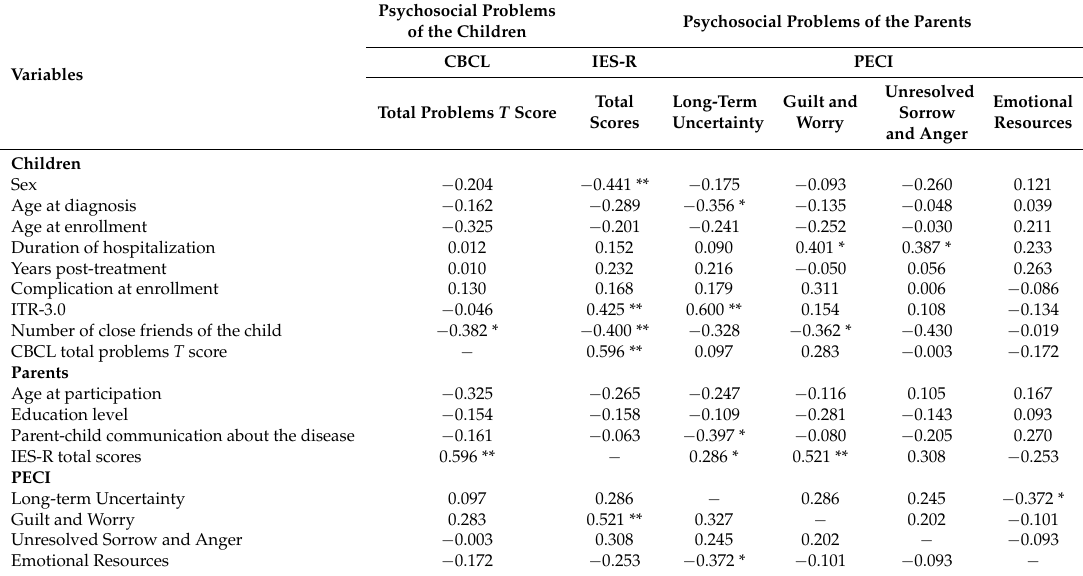
Table 3. Correlations of demographic, medical, and psychosocial factors of the children with cancer and their